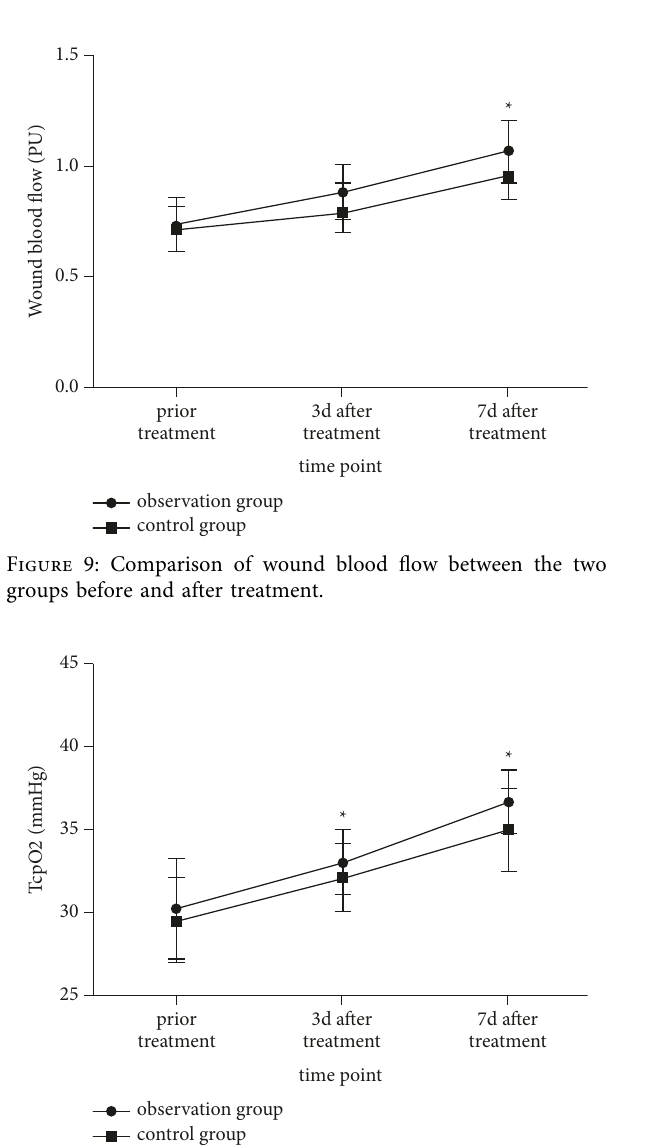
Figure 10: Comparison of TcpO 2 between the two groups before and after treatment.